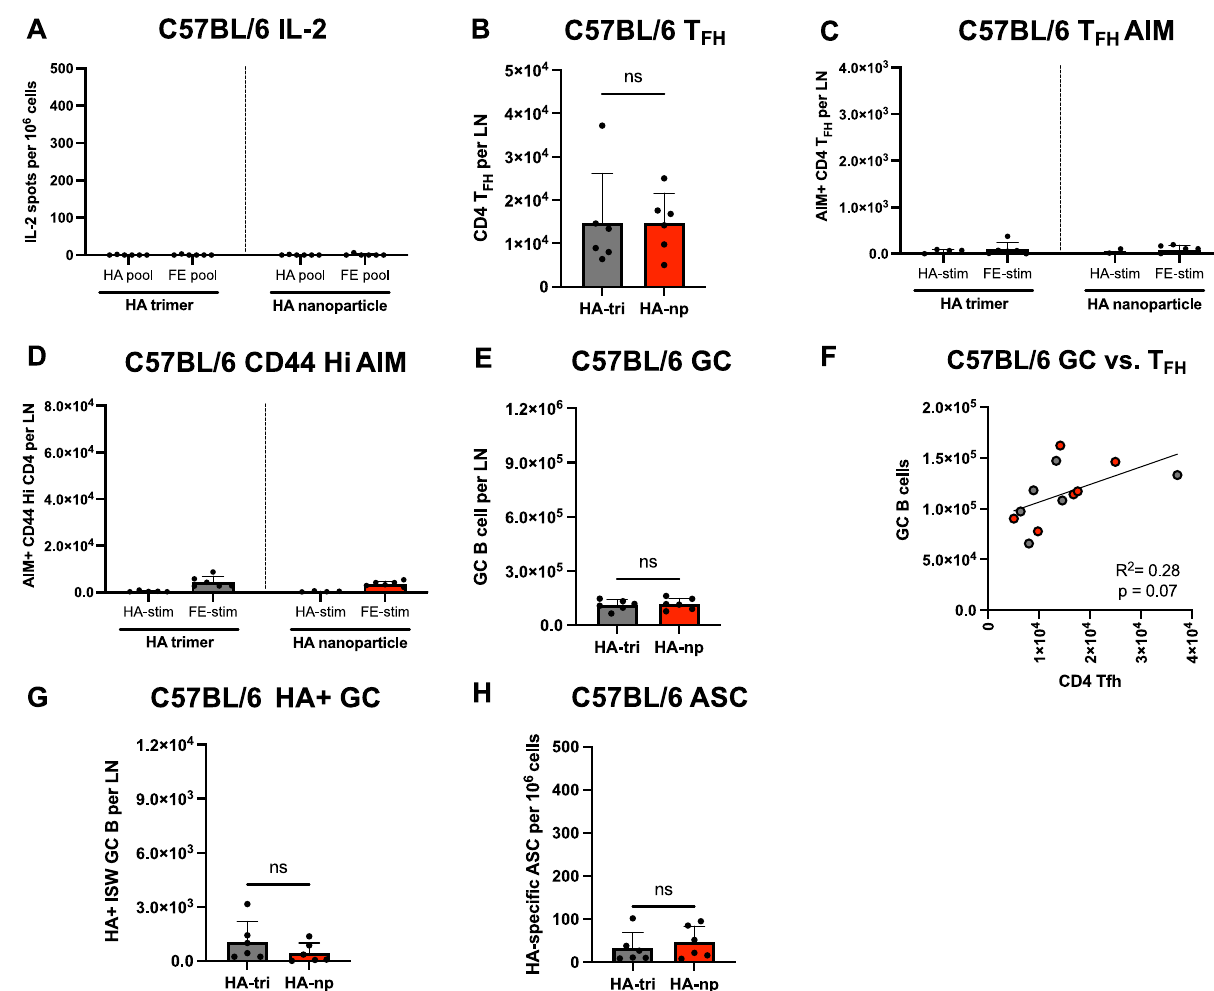
Fig. 5 Equivalent vaccine responses to HA-trimers and HA-nanoparticles in H-2b MHC II haplotype mice lacking major CD4 T cell epitopes. C57BL/6 mice were immunized with equimolar quantities of HA in the form of soluble HA trimers or HA-nanoparticles. Draining lymph nodes were harvested D15 post immunization. Antigen-speci fi c CD4 T cell responses were quanti fi ed by IL-2 ELISpot for A following stimulation with total HA or total ferritin peptide pools. Absolute numbers of CD4 T FH per lymph node were quanti fi ed B . Antigen speci fi city of the T FH response was quanti fi ed by activation induced marker (AIM) assay by scoring upregulation of CD154 and CD69 in response to peptide stimulation C . Quanti fi cation of antigen experienced non-T FH that upregulate CD154 and CD69 in response to peptide stimulation D . Total abundance of FAS + GL7 + GC B cells per lymph node was assessed in E mice immunized with equimolar quantities of HA in the form of soluble HA trimers or HA-nanoparticles from the same individual mice shown in Fig. 5. The relationship between GC B cell abundance and CD4 T FH abundance was assessed by linear regression analysis F . Antigen-speci fi c GC B cell responses were assessed by staining with fl uorophore conjugated HA probes, where the B cell population of interest was de fi ned as FAS + GL7 + IgM- IgD- HA + G . HA-speci fi c ASCs were assessed by B cell ELISpot H . Data are shown as the mean and SD of three individual mice per group from two independent experiments, for a total of 6 individual mice per group. In A , C , D , signi fi cant differences between HA-trimer and HA-nanoparticle immunized mice were determined by two-way ANOVA with Tukey ’ s correction for multiple comparisons. In B , E , G , H , signi fi cant differences between HA-trimer and HA-nanoparticle immunized mice were determined by unpaired, two-tailed Mann-Whitney (2.2 μ g) of HA-trimer in the presence of Sigma Adjuvant System ®